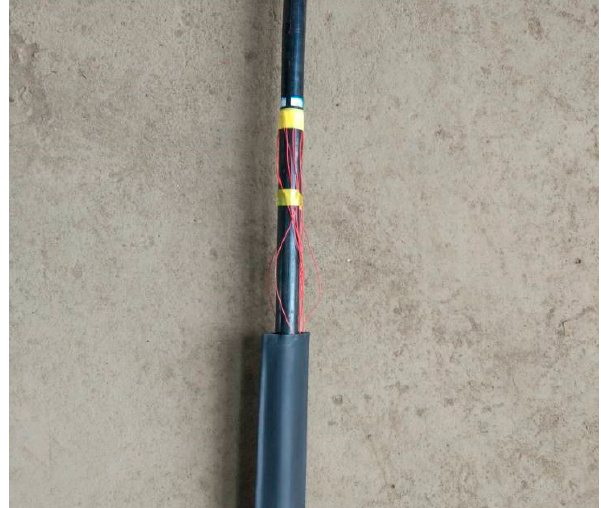
Figure 6. Attachment and silicone-based waterproof treatment of strain gauges.